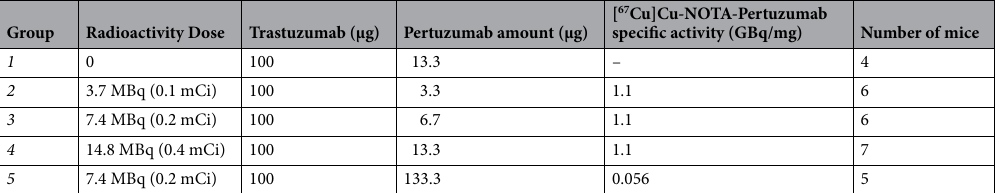
Table 2. Dosing information for control Group 1 and treatment Groups 2 – 5